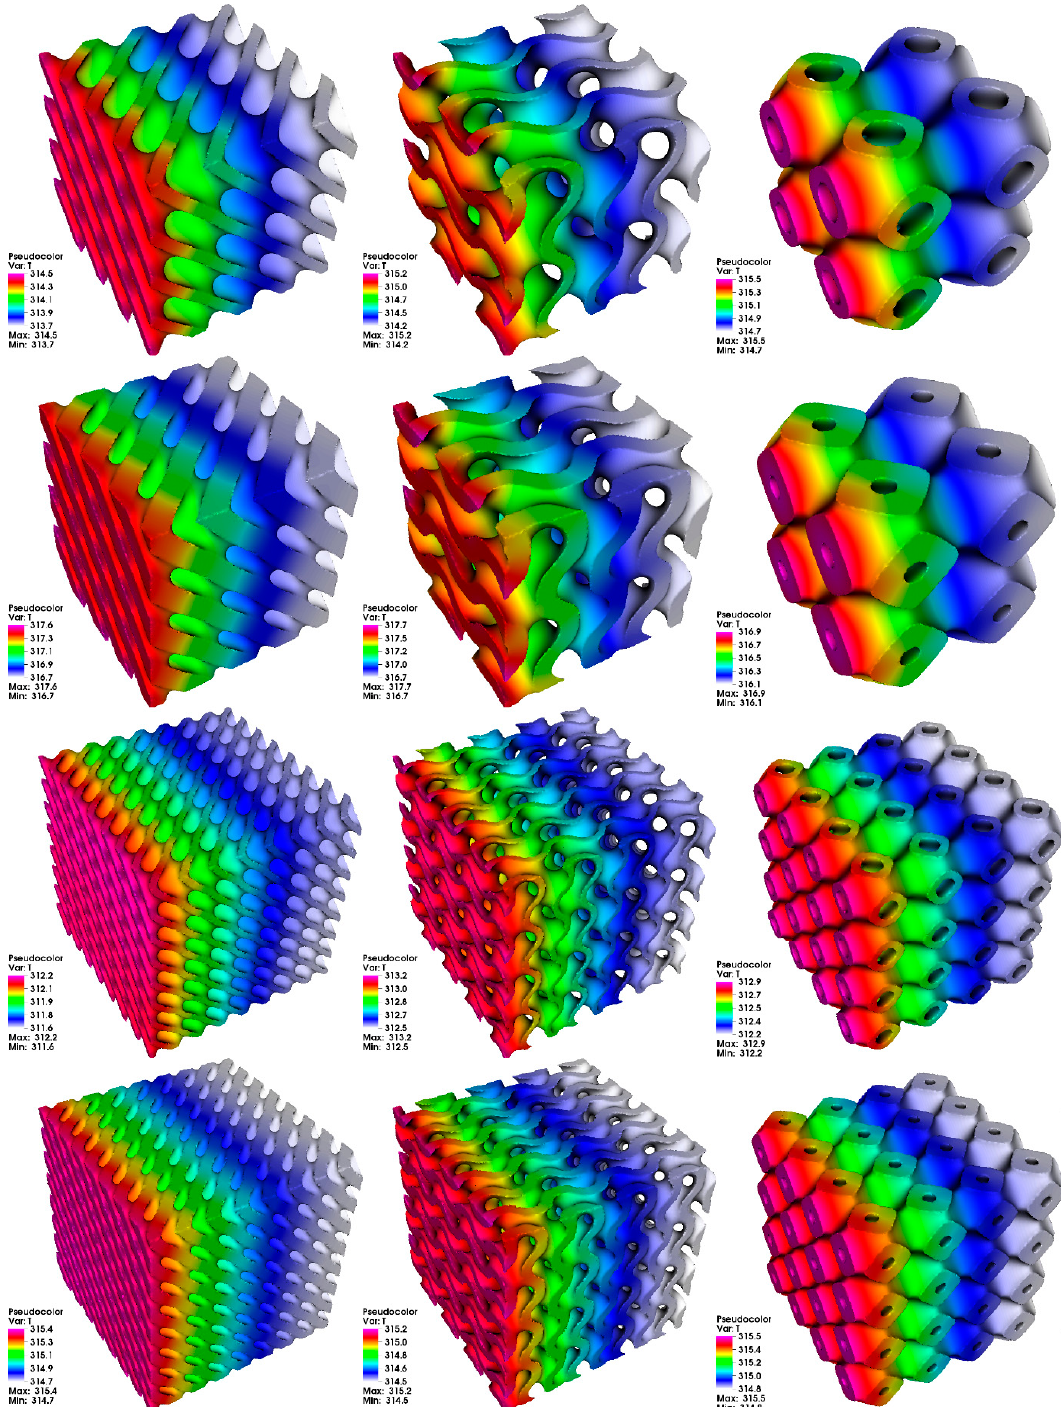
Figure 1. The results of heat simulation after 250 s. Columns from left to right: diamond (D) surface, gyroid (G) surface, primitive (P) surface. Rows from top to bottom: 2 cells, thickness δ = 0.125; 2 cells, thickness δ = 0.2; 4 cells, thickness δ = 0.125; 4 cells, thickness δ =